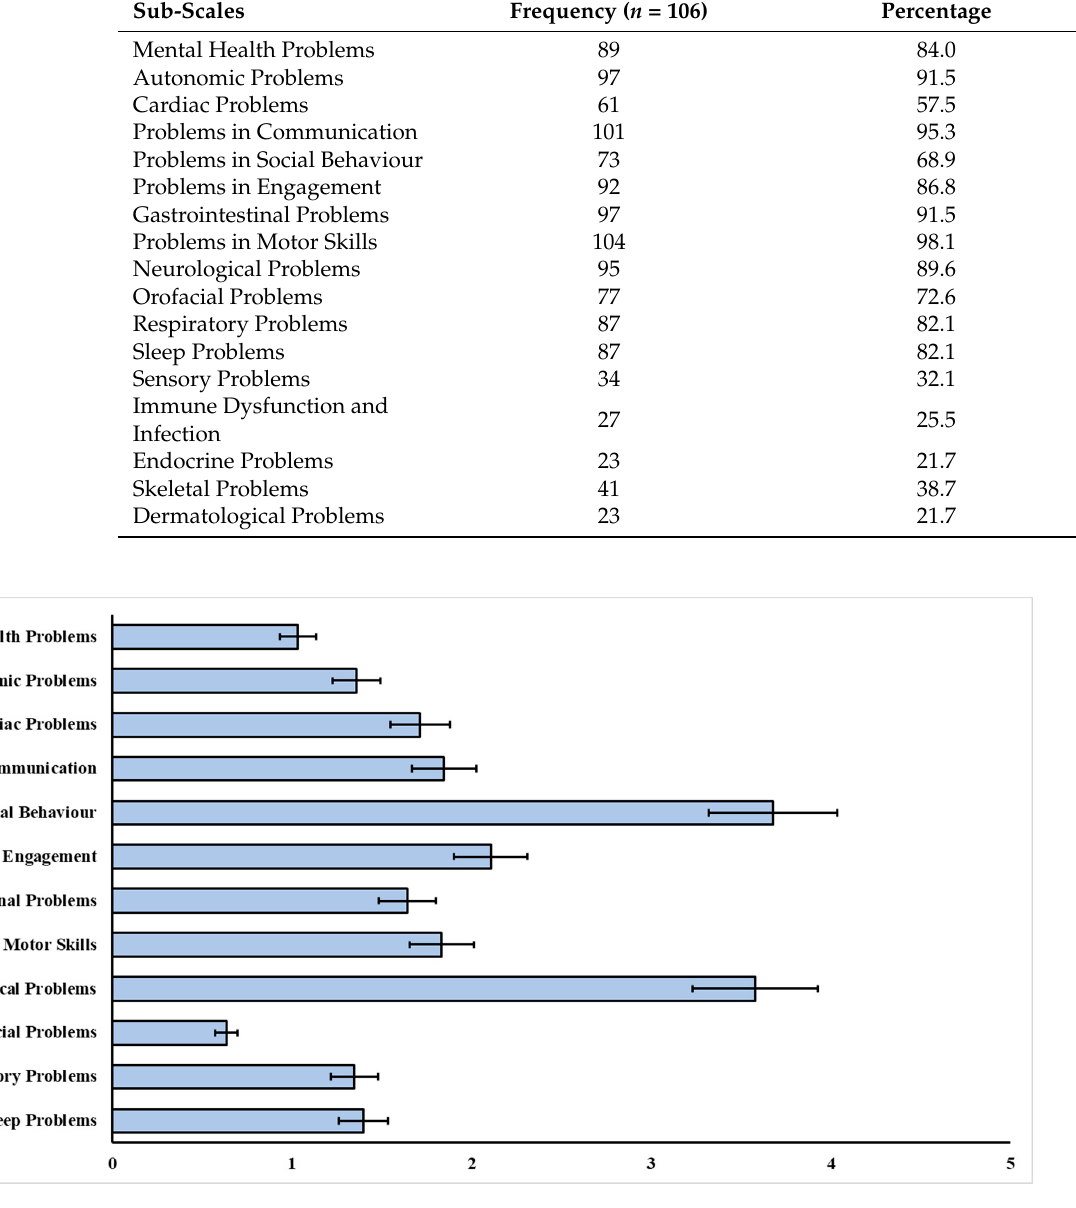
Table 4. Cronbach’s alpha and intraclass correlation coefficient.